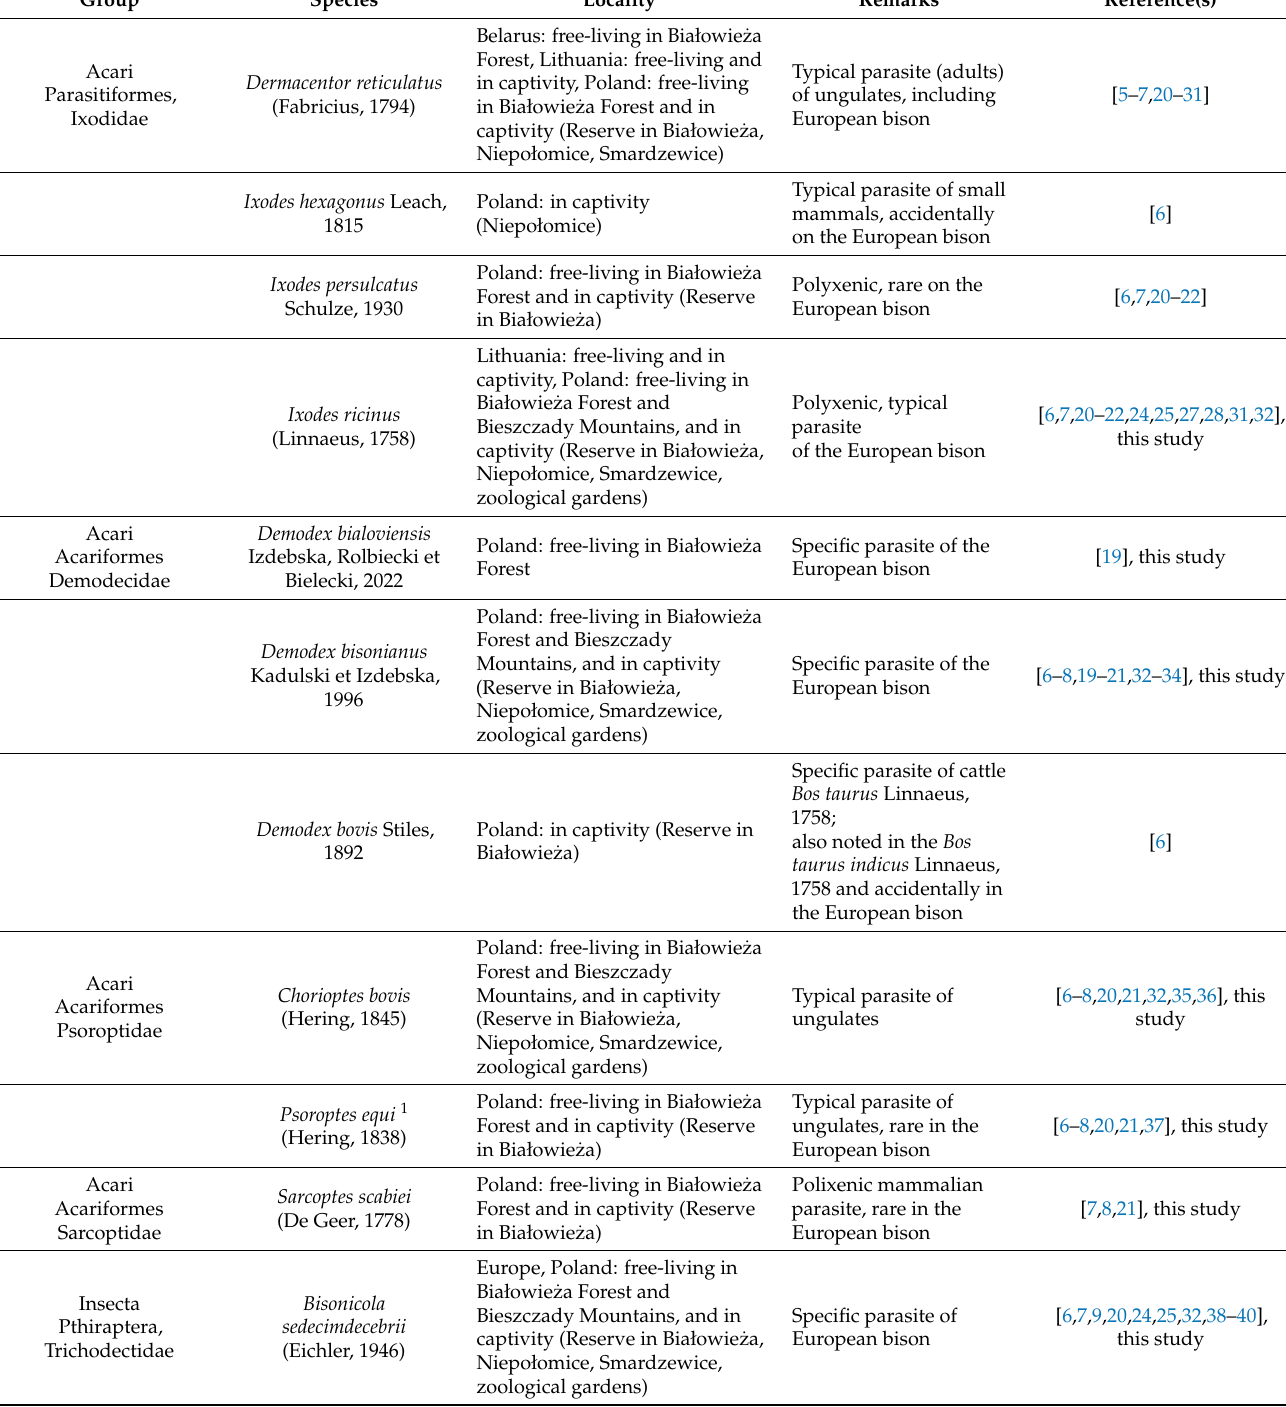
Table 2. Parasitic arthropods associated with European